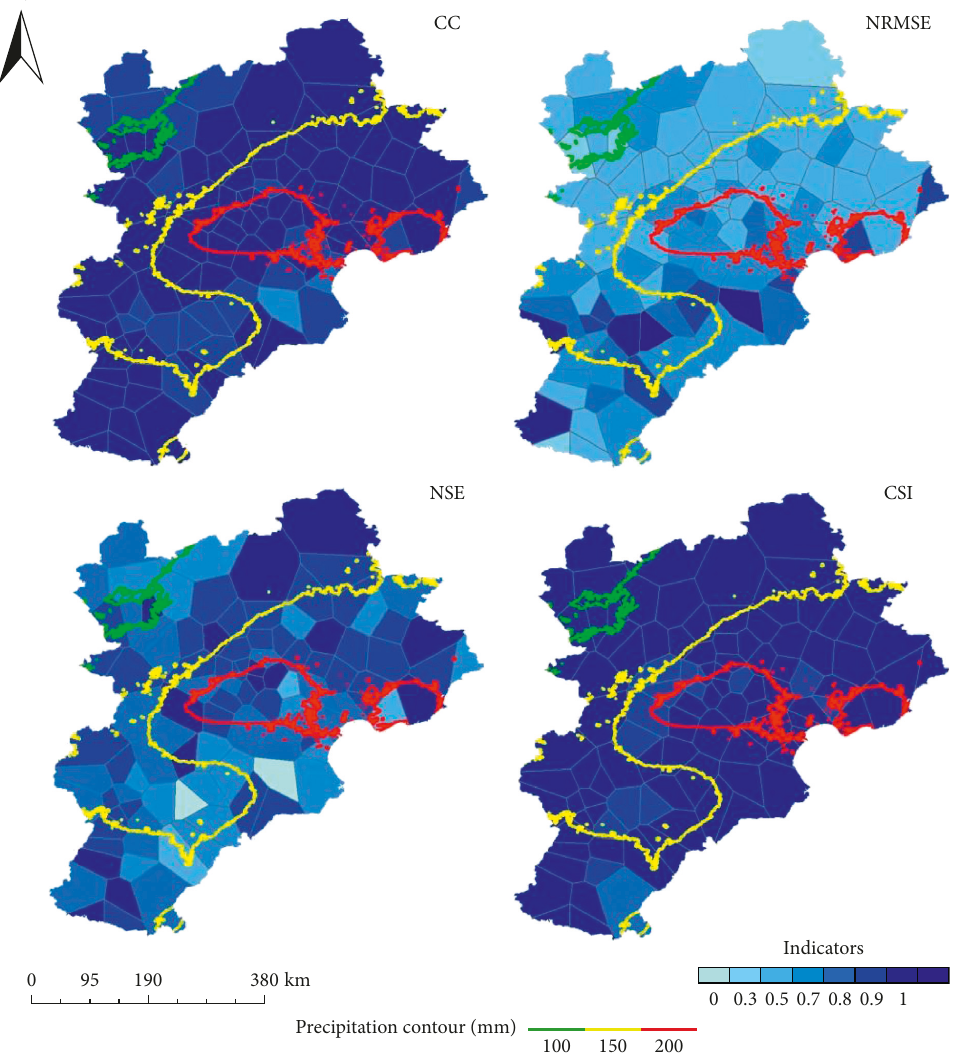
Figure 4: Spatial distribution of CC, NRMSE, NSE, and CSI based on GPM-M products.